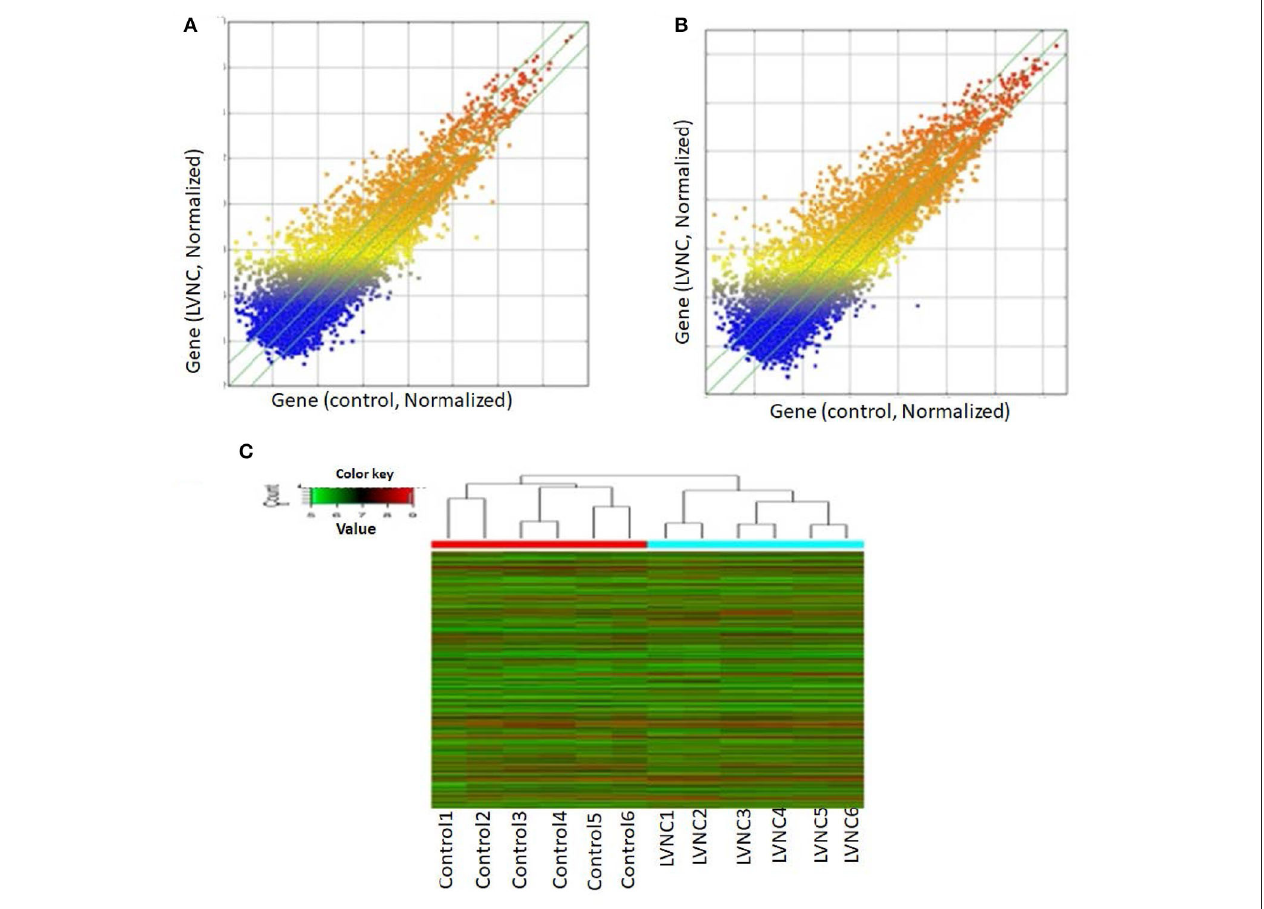
FIGURE 1 | Using arraystar human long noncoding RNAs (lncRNA) microarray V3.0. Two thousand six hundred eighty-two lncRNAs (log fold- changes > 2.3) were detected. The scatter plot is a visualization method used for assessing the lncRNAs (A) and mRNAs (B) expression variations between left ventricular noncompaction (LVNC) and the control group. The values of the X and Y axes in the scatter plot are the averaged normalized signal values of the group (log2 scaled). The green lines are fold-change lines. (C) Differentially expressed lncRNAs and mRNAs in plasma of LVNC and the control were analyzed using hierarchical clustering. Hierarchical clustering analysis arranges samples into groups by expression level, “red” indicates high relative expression, and “green” indicates low relative expression.